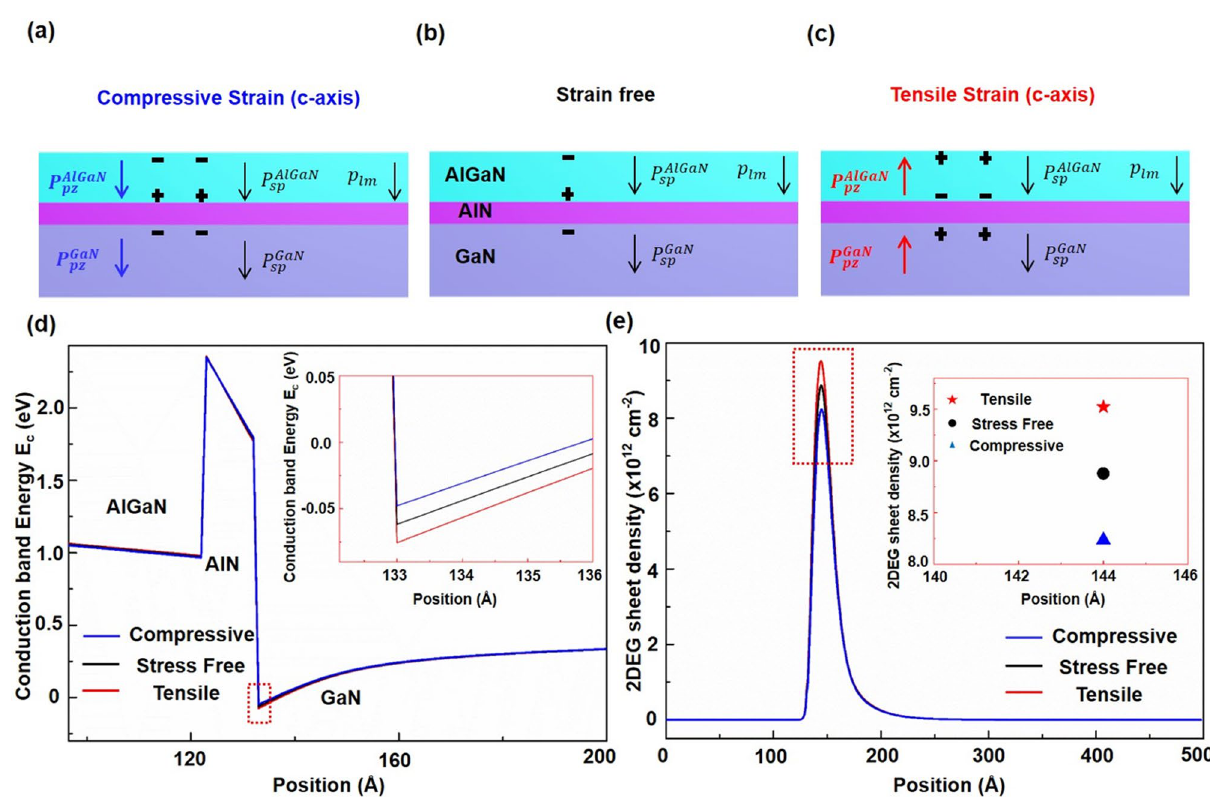
Fig. 6 Working mechanism of the piezotronic effect and Self-consistent calculation of energy profiles and 2DEG sheet density. The coupling of piezotronics-induced polarization and intrinsic polarization (p sp ;p lm ), corresponding energy band profiles, and distribution of 2DEG in AlGaN/ AlN/GaN HEMTs under b strain free, a compressive and c tensile strain states. d The conduction band energy profiles under compressive strain state (blue line); stress free state (black line); tensile strain state (red line). e The sheet density of 2DEG under compressive strain state (blue line); stress free state (black line); tensile strain state (red